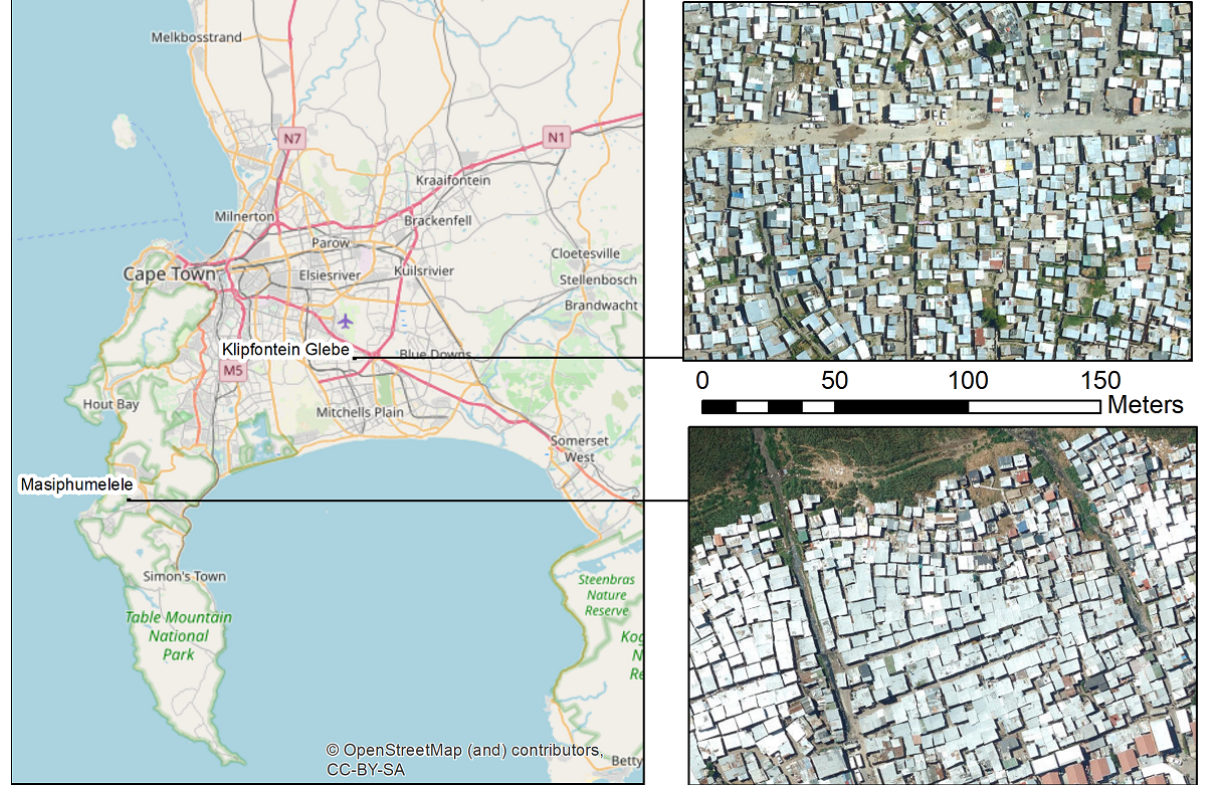
Figure 1. City of Cape Town and the location of Masiphumelele and Klipfontein